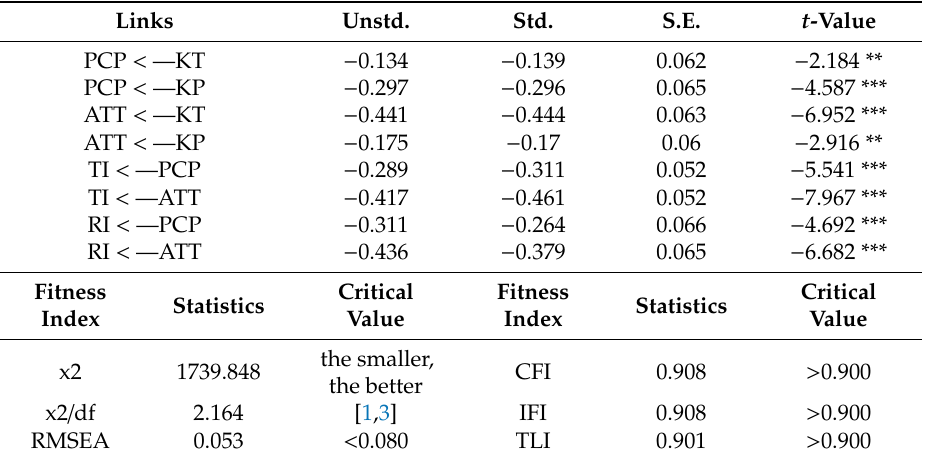
Table 6. Path analysis results.